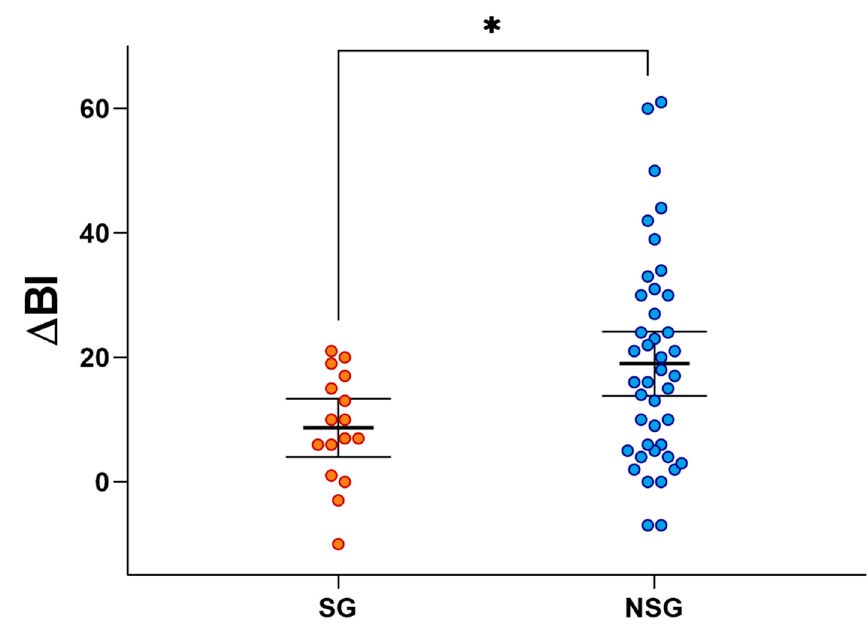
Figure 2. Distribution of the change from baseline of the modified Barthel Index ( ∆ BI) after 6 weeks of rehabilitation in Non-Sarcopenic Group (NSG, n = 42) and Sarcopenic Group (SG, n = 16). Mean bars and 95% CI are reported. * Refers to the statistically significant difference ( p value = 0.038).